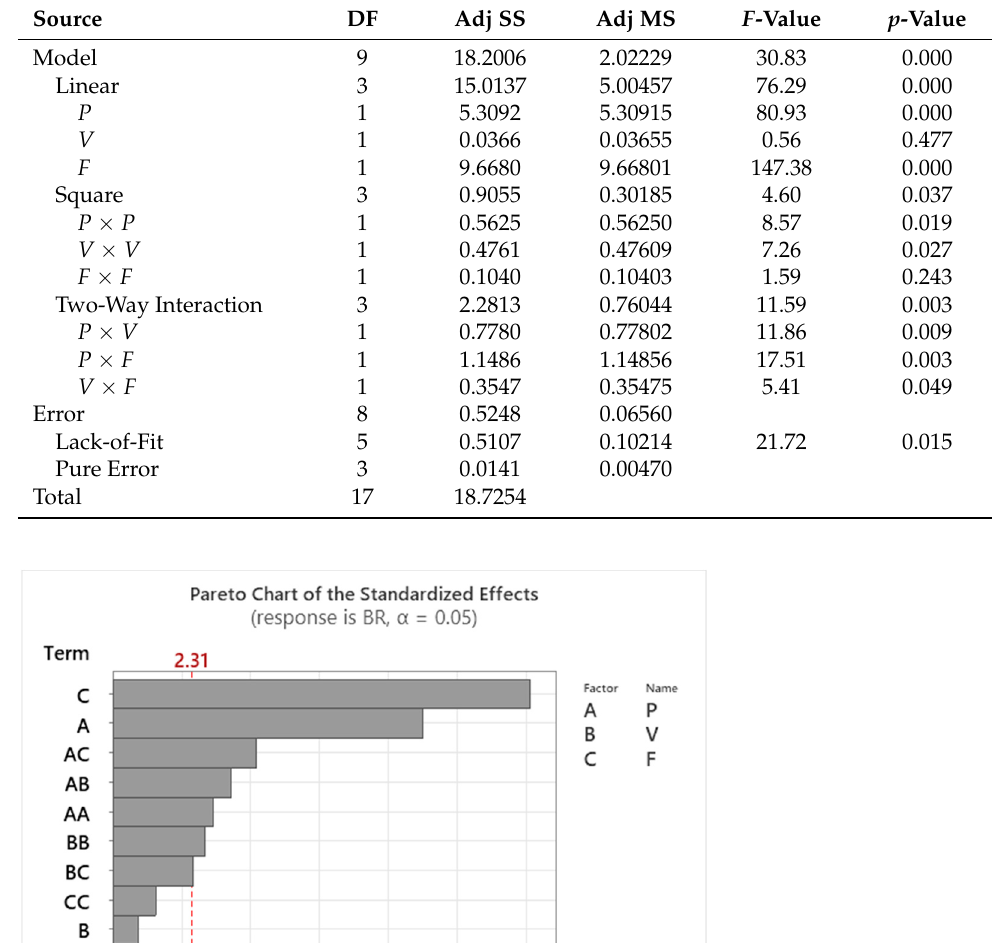
Table 5. ANOVA analysis of BR .